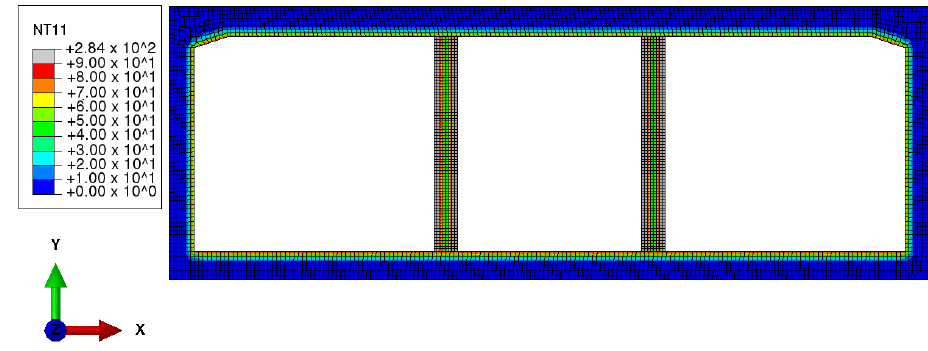
Figure A2. Temperature distribution obtained by prescribing three piecewise uniform surface temperature histories, 30 min after the start of the thermal loading: overview over the whole structure.